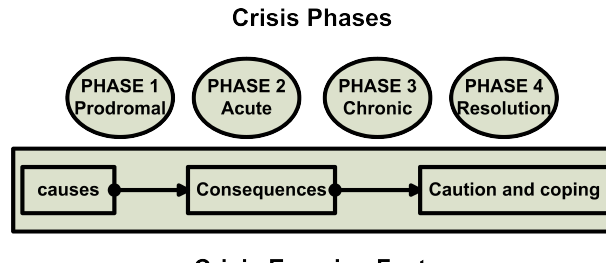
Figure 1. Crisis